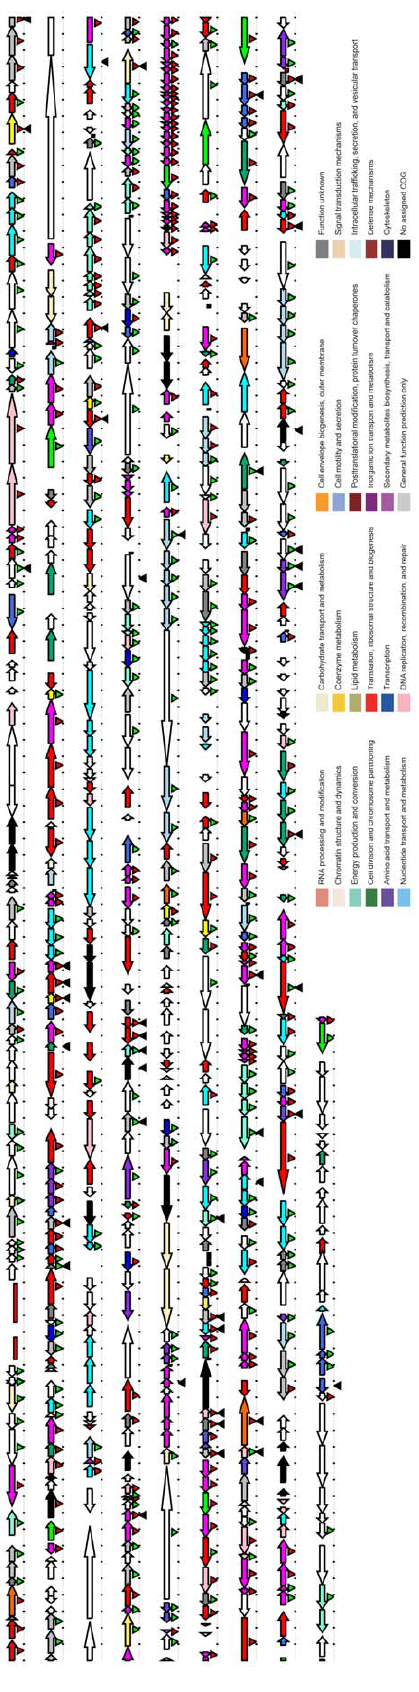
Figure 3. Viable core and pan genes distribution in the M. hyorhinis HUB-1 map. The M. hyorhinis HUB-1 genome is shown at a scale of 100 kb per line. Colored arrows above the line indicate annotated genes. Genes are colored according to their functional category, as indicated in the key. rRNAs and tRNAs are denoted by red and purple rectangles, respectively. Red triangles above the line represent the core genes of Mycoplasmataceae . Blue triangles above the line represent the genes shared by all the species in clade III, but which are absent from other lineages. Black triangles below the line represent the disrupted genes documented in M. genitalium G37, mapped onto the M. hyorhinis HUB-1 genome